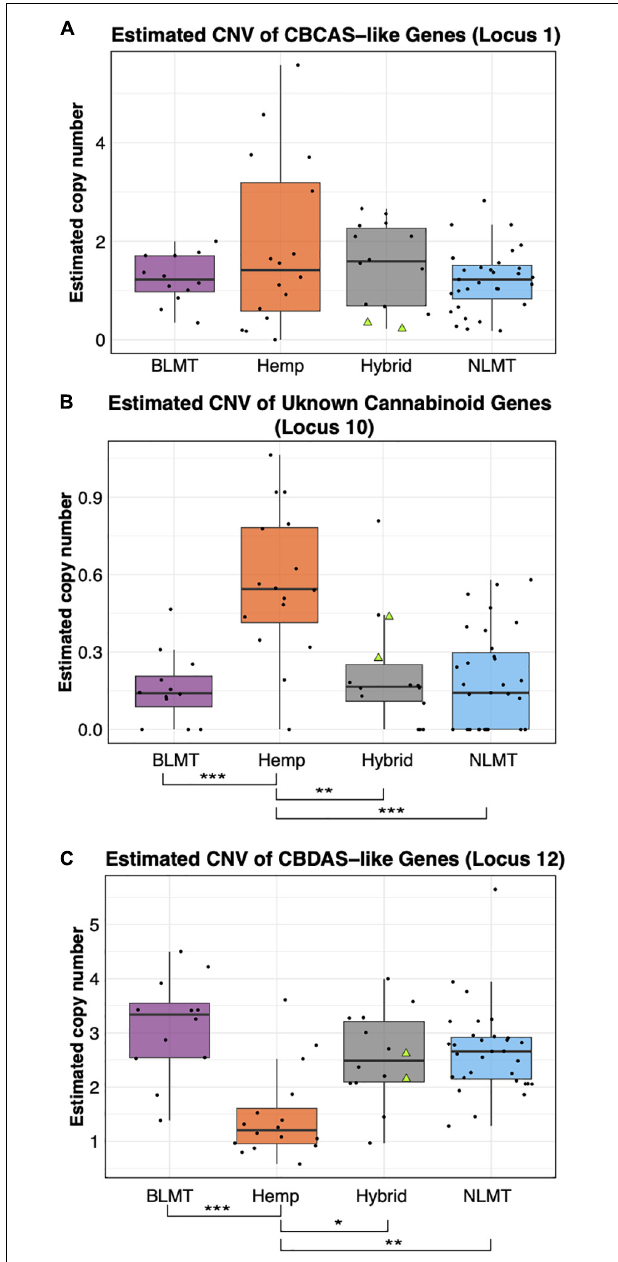
FIGURE 4 | Copy Number Variation in cannabinoid genes. The estimated copy number of the CBCAS-like genes (A) is not different between groups despite the Hemp lineage having the widest range. Another unknown cannabinoid locus (B) shows significant differences between Hemp and the other groups at the P < 0.001 level. The Hemp lineage also differs significantly with a P < 0.01 from the other lineages in the estimated copy number